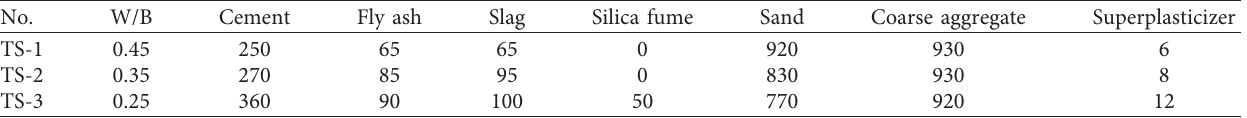
Table 2: Mix proportion of concrete (kg/m 3 ).